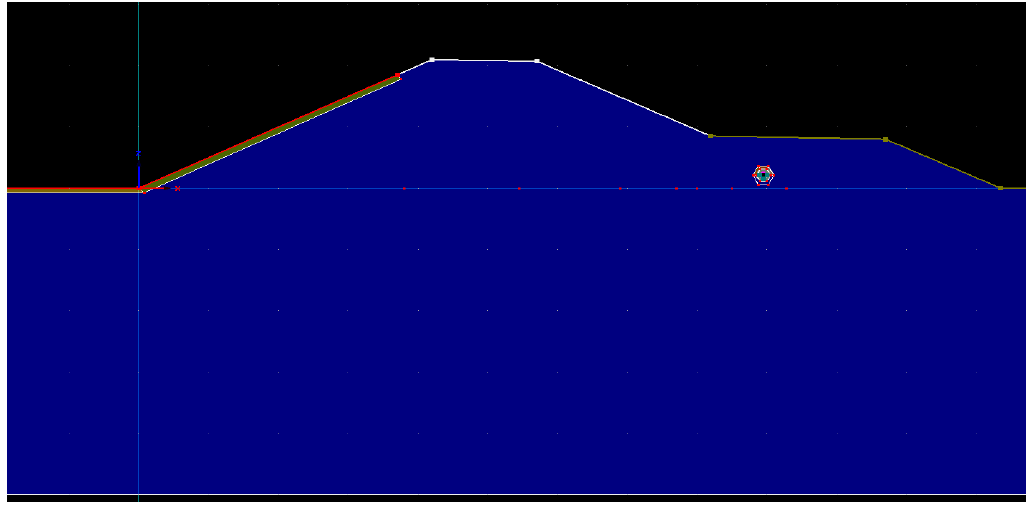
Figure 7. Numerical scheme built in software package HYDRUS (two-dimensional/three- dimensional (2D/3D)).